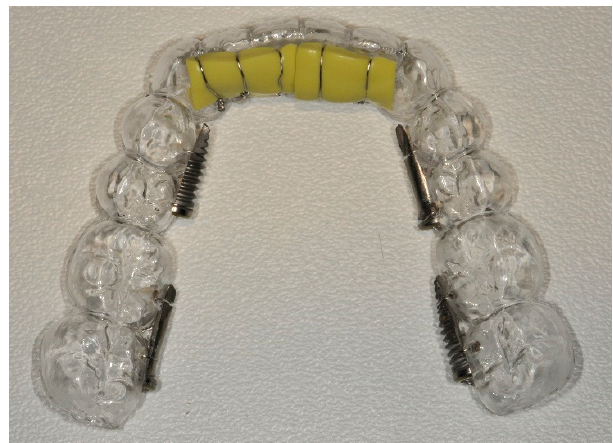
Figure 1. Customized thermoplastic mouth tray.